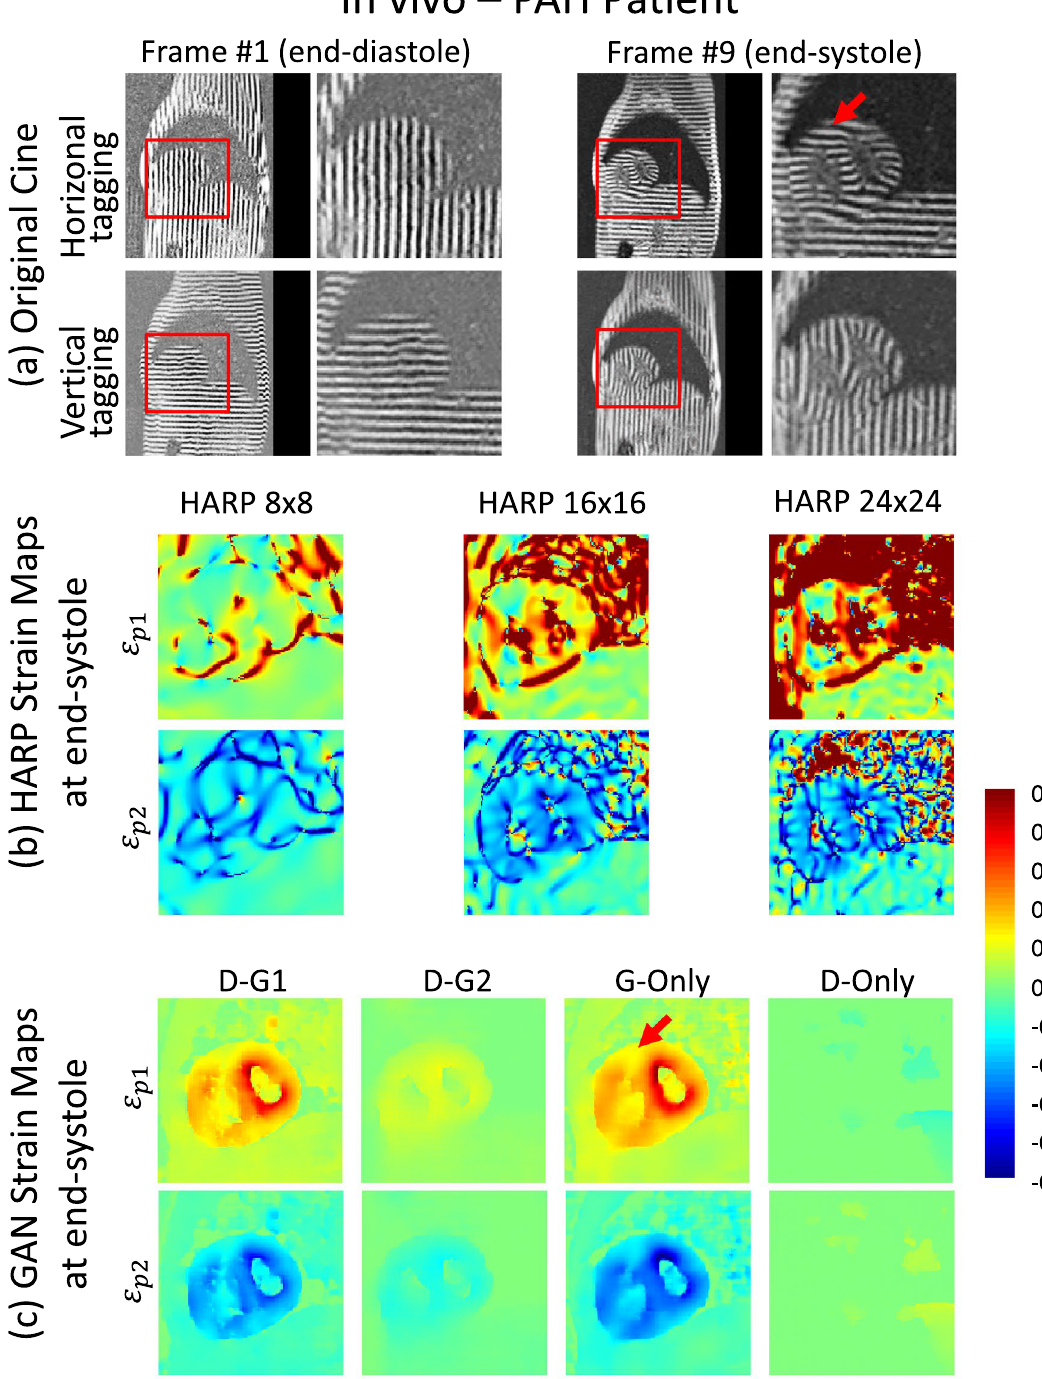
Figure 5. In-vivo demonstration of the strain maps generated by G-Only versus HARP in a PAH patient. ( a ) Raw tagging images of the end-diastole and end-systole time frames. ( b ) Various HARP-based strain maps. ( c ) GAN-based strain maps with different cost functions. High-resolution boundaries of the enlarged left and right ventricles are visible, and strain characteristics of PAH disease such as higher strain magnitude and low strain at the RV-LV insertion point (red